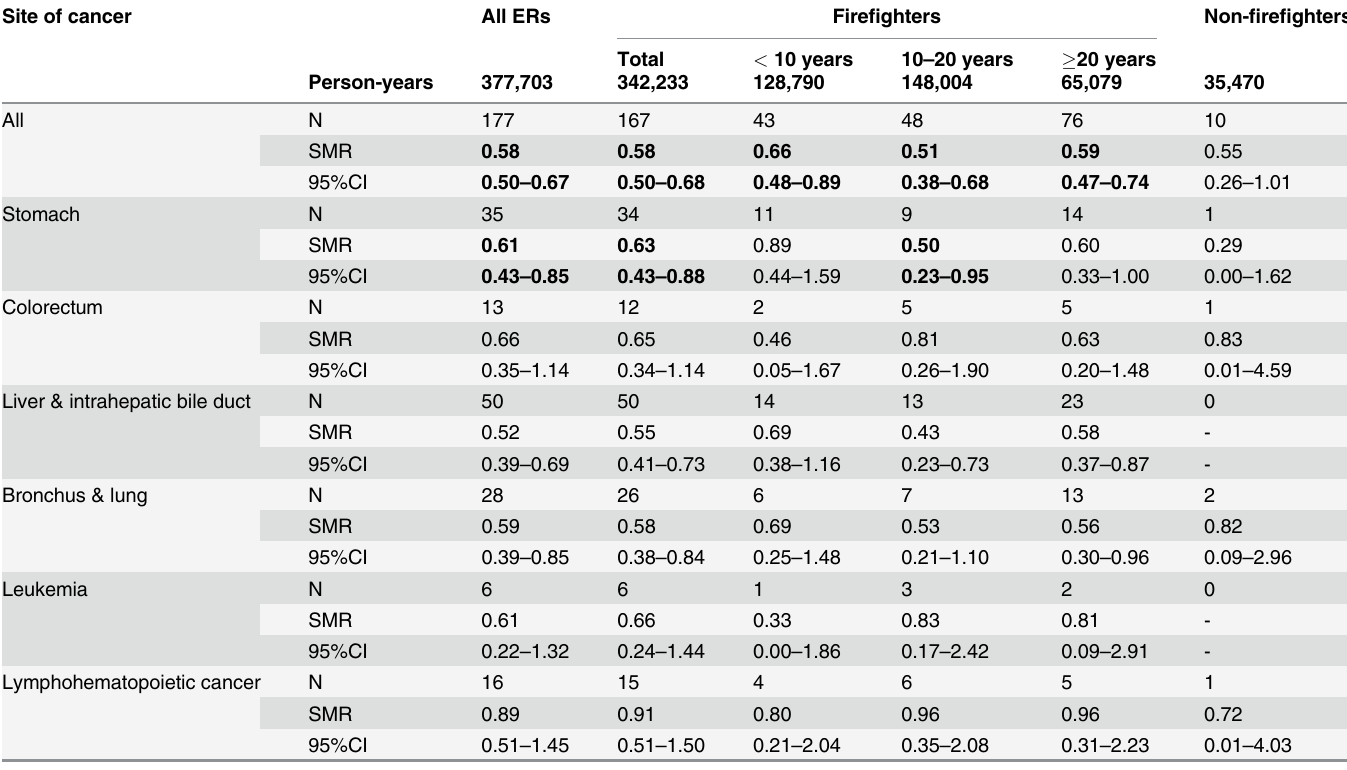
Table 3. Mortality (SMR) due to cancer in emergency responders (ERs) (reference: Korean men). Site of